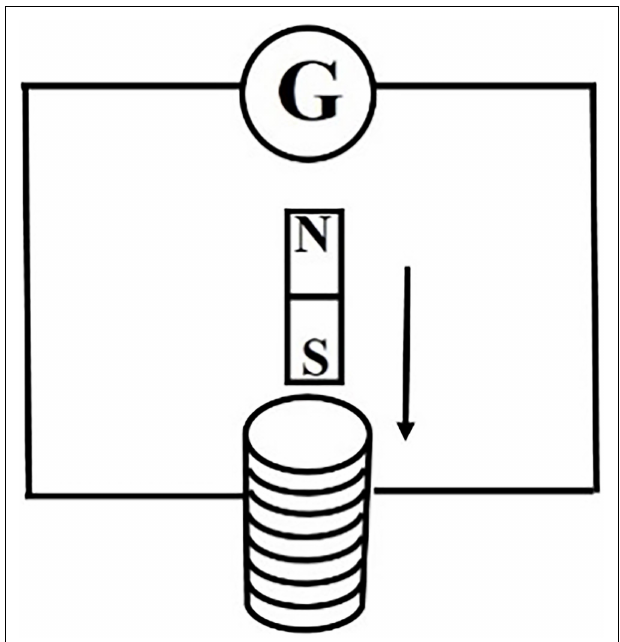
FIGURE 5 | Experimental circuit i of EIP = 0 level remedial teaching scheme.